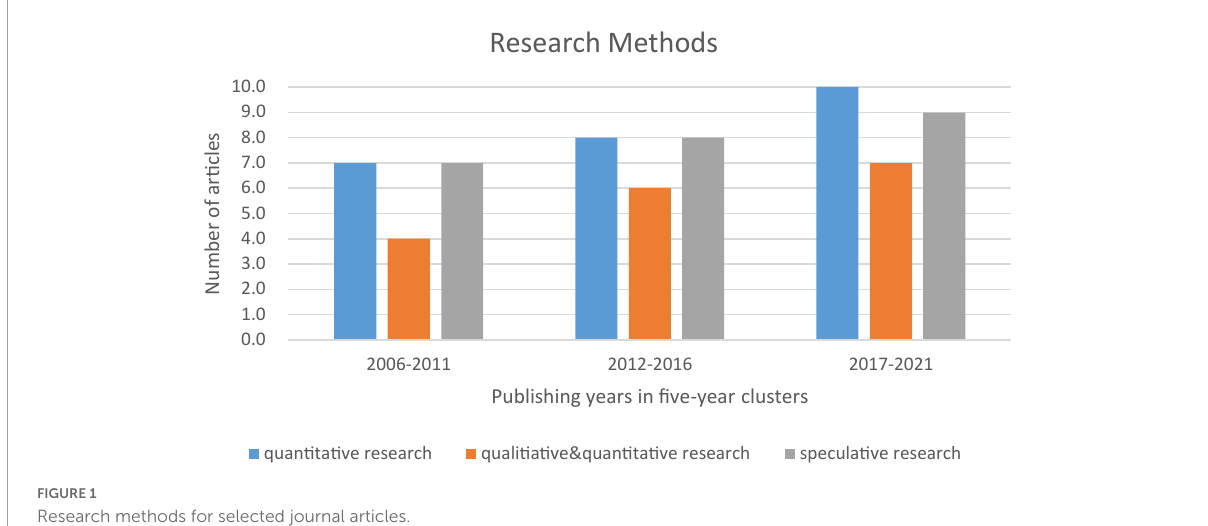
FIGURE1 Research methods for selected journal